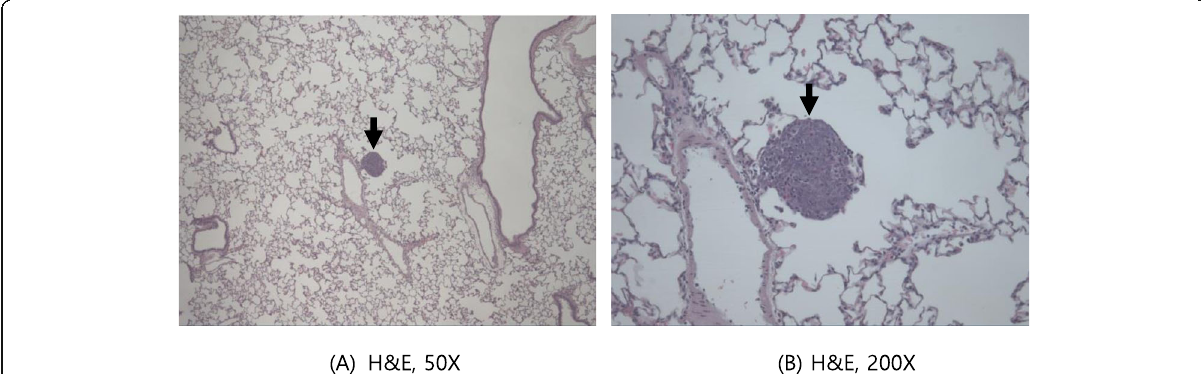
Fig. 7 Basal cell carcinoma metastasis in the lung (tumor cell nodule) of female G3 (middle dose group; rat number 2302) ( a ) H&E 50X ( b